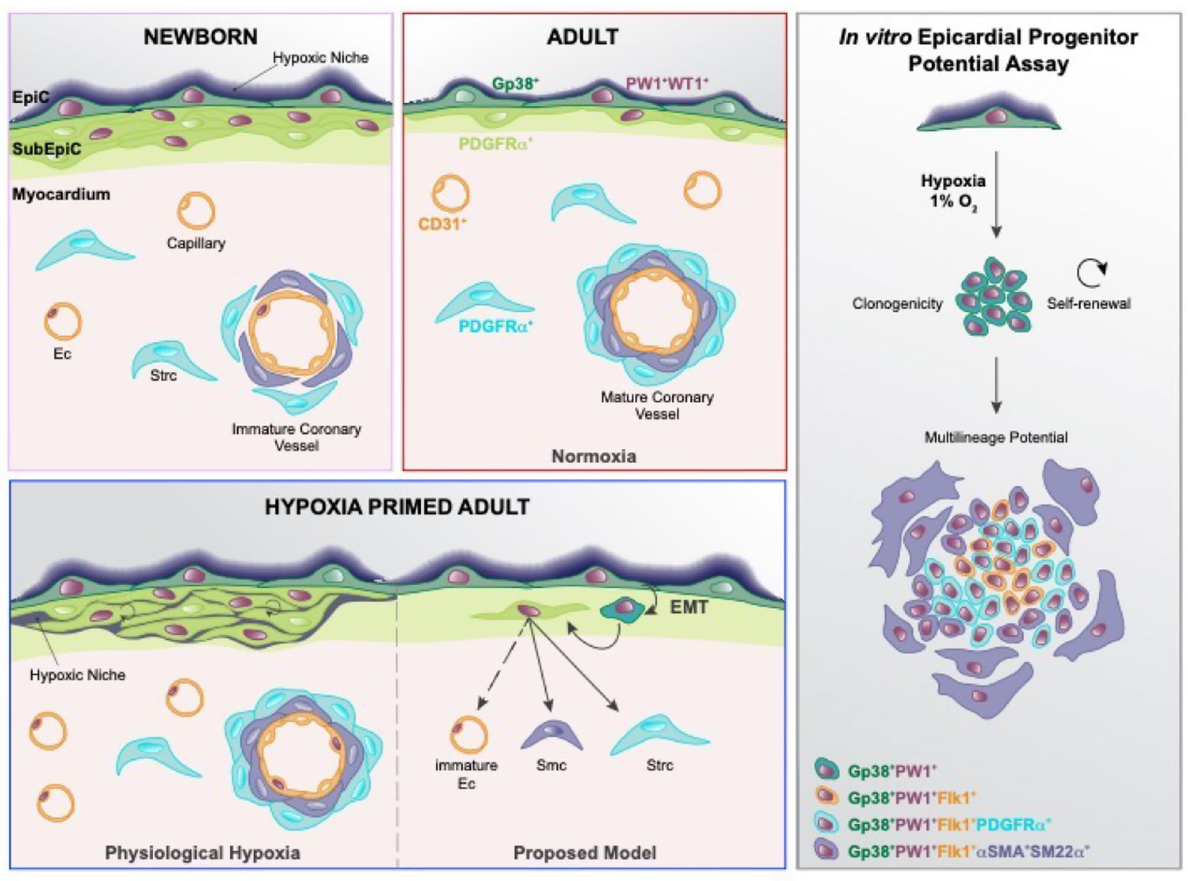
Figure 6. Proposed model for hypoxia activation of the adult murine epicardium to a progenitor cell function and multipotency. Epicardium is an active reservoir of progenitor cells that gives rise to coronary vasculature and stroma cells during perinatal life. The adult mammalian epicardium is a heart resident progenitor niche that maintains PW1 and WT1 expression, and a hypoxic environment. Hypoxia-primed epicardium activation induces a progenitor profile and shows multilineage differentiation ability (stromal and smooth muscle lineages) and the upregulation endothelial lineage markers, similarly to the perinatal epicardial profile. This figure was generated using Adobe Illustrator CC 2019 Version 23.0.2 (https:// www. adobe. com/